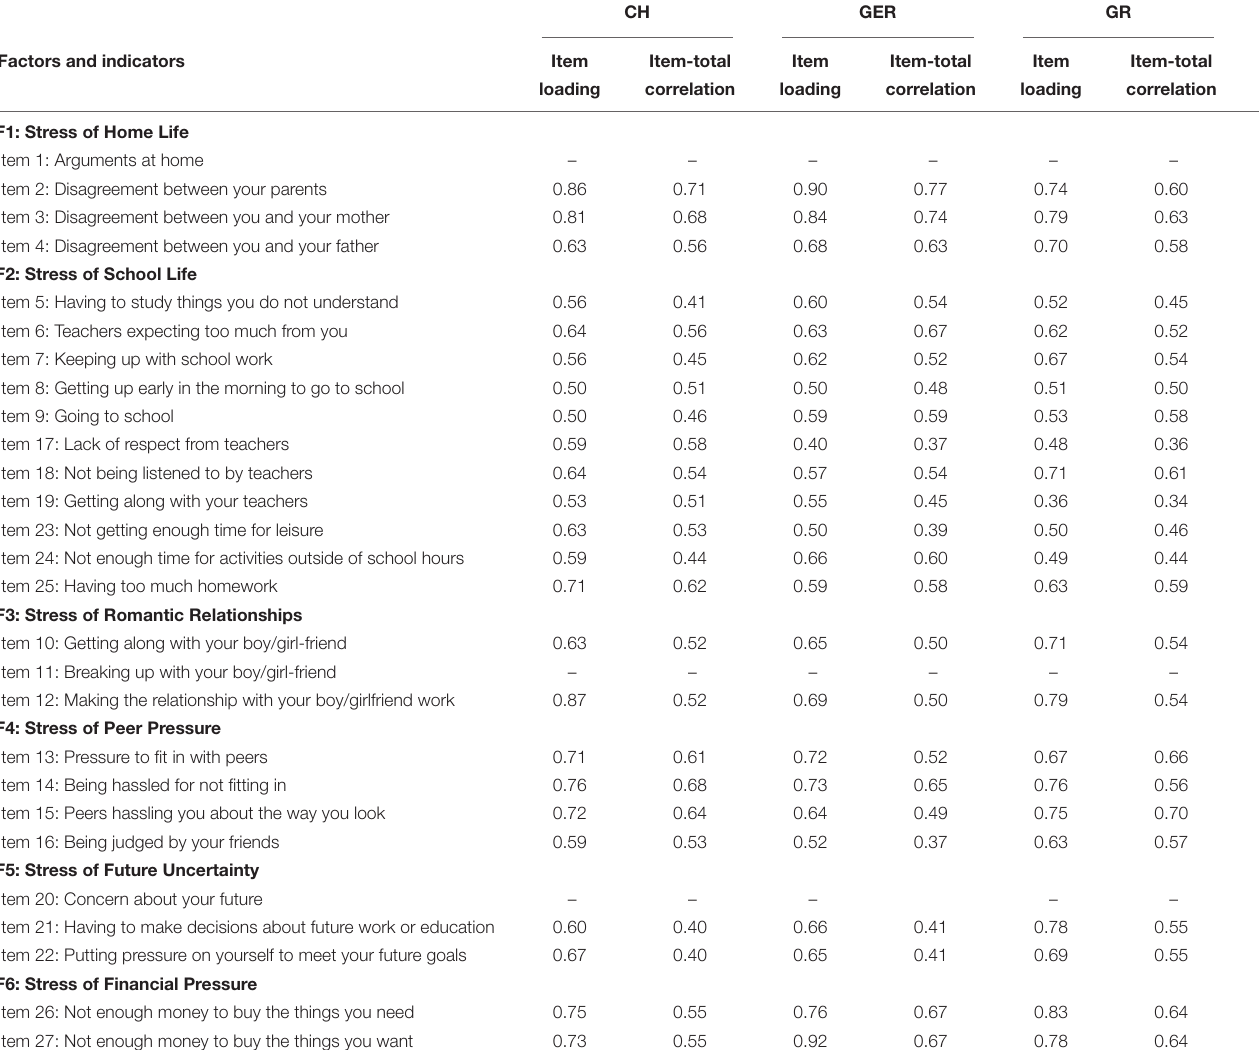
TABLE 3 | 6-factor structure of the adolescent stress questionnaire-shortened version (ASQ-S); standardized loadings and item-total correlations. CH GER GR Factors and indicators Item Item-total Item Item-total Item Item-total loading correlation loading correlation loading